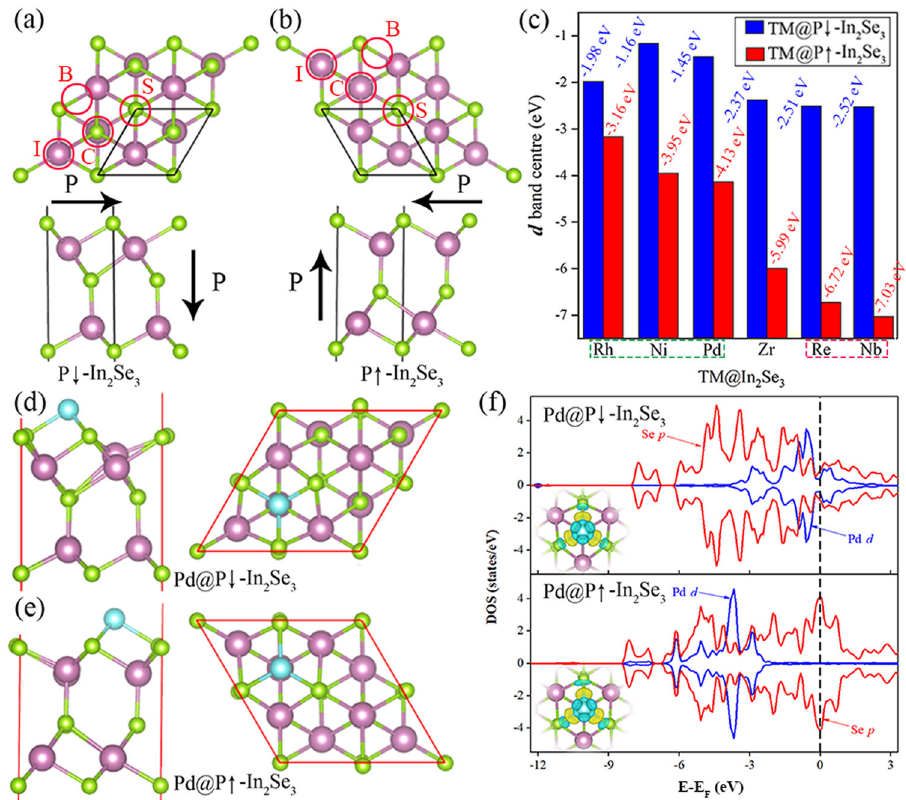
Fig. 1 Geometries and electronic structures of the ferroelectric catalysts. Top and side views of the optimized α -In 2 Se 3 monolayer with a downward (P ↓ ) and b upward (P ↑ ) polarization. Red circles denote selected adsorption sites: I, top of the In atom; C, center of the six-membered ring; B, top of the In-Se bond; S, top of the Se atom. The black rhombus represent the unitcell of In 2 Se 3 . c The d band center of TM@In 2 Se 3 (TM = Ni, Pd, Rh, Zr, Nb and Re). Top and side views of the optimized con fi guration of d Pd@P ↓ -2×2 In 2 Se 3 and e Pd@P ↑ -2×2 In 2 Se 3 , the supercell is indicated by the red rhombus. f The partial density of states of Pd@P ↓ -In 2 Se 3 and Pd@P ↑ -In 2 Se 3 . The insets show the 3D differential charge density plots obtained with the model shown in Fig. 1d and e. The isosurfaces are 0.005 e/Å 3 . Charge accumulation and depletion are marked by the yellow and blue regions,